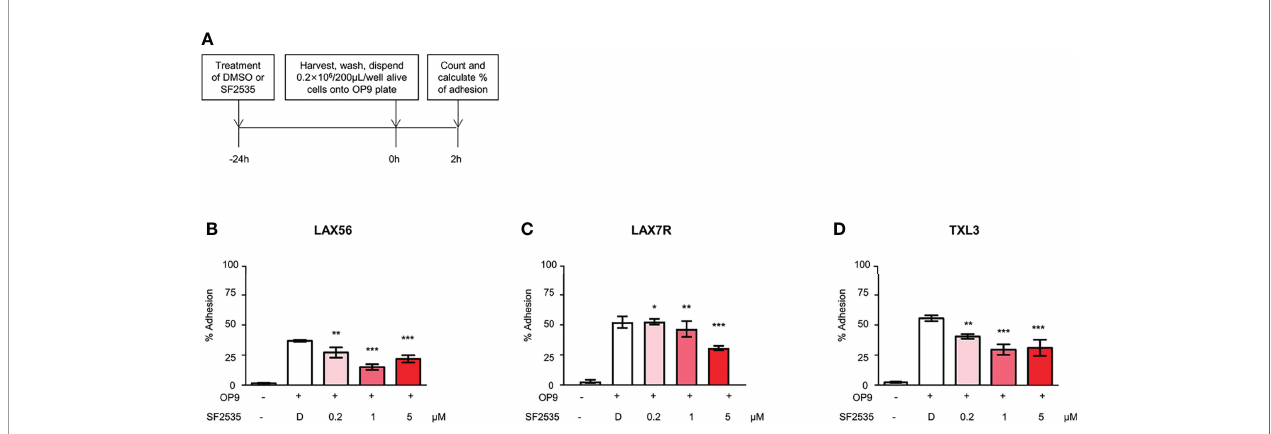
FIGURE 5 | SF2535 moderately inhibits B-ALL adhesion to OP-9 cells. (A) Schema of adhesion assays. (B) LAX56, (C) LAX7R, and (D) TXL3 cells were treated with DMSO (D) or SF2535 for 24 hours. After harvest and wash, 0.2×10 6 alive cells per well were placed on pre-seeded OP9 cells plate for 2 hours. Adhesion and supernatant cells were counted by Trypan Blue exclusion. Percentage (%) of alive adhesion cells were presented. Experiments were performed in triplicates. *P < 0.05, **P < 0.01, ***P < 0.001 compared to DMSO